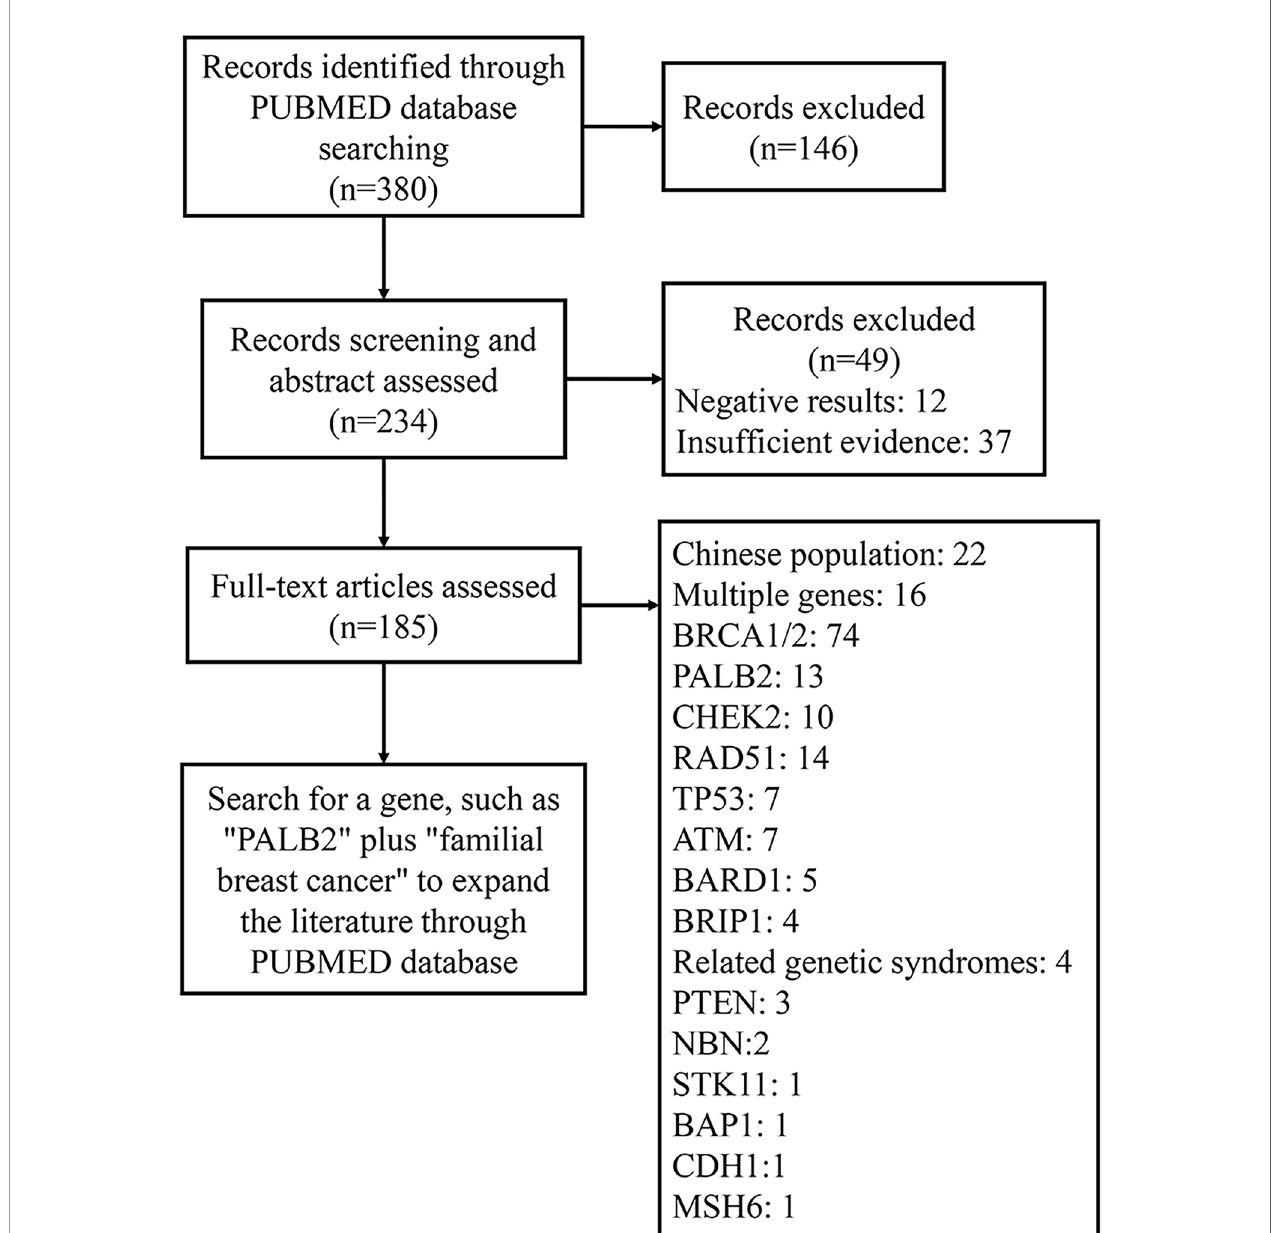
FIGURE 1 | Literature screening